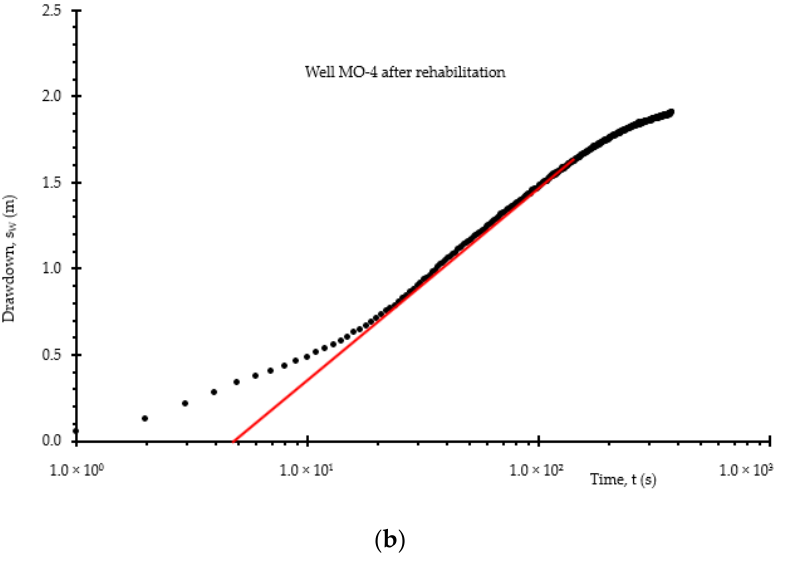
Figure 10. Well MO-4 pumping tests before ( a ) and after ( b ) rehabilitation (for the early portion of pumping test the red straight line is used in the software [50] for evaluation of the skin factor).